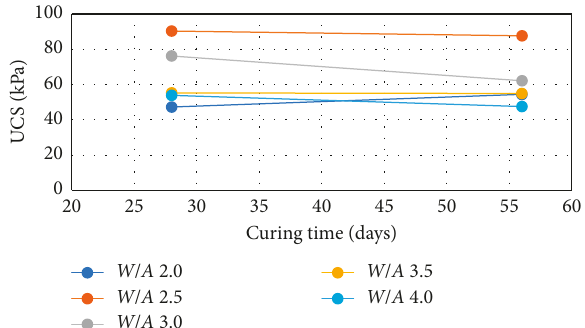
Figure 9: UCS value vs. curing time for peat C specimens ( w 380%). (cid:31)